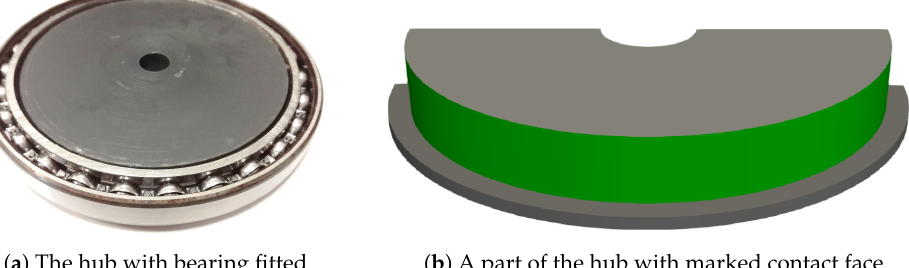
Figure 2. The assembly of the hub and the bearing.